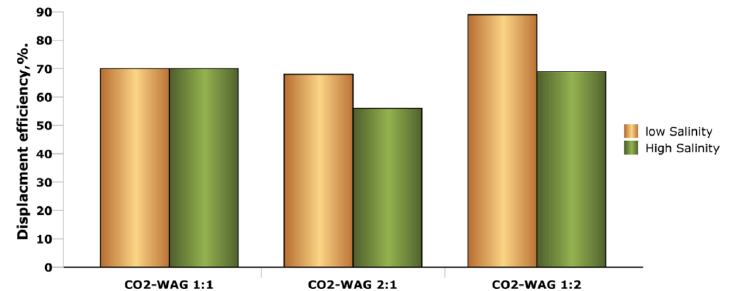
Figure 7. Effect of WAG ratios on oil recovery in CO 2 HS and LS WAG injection